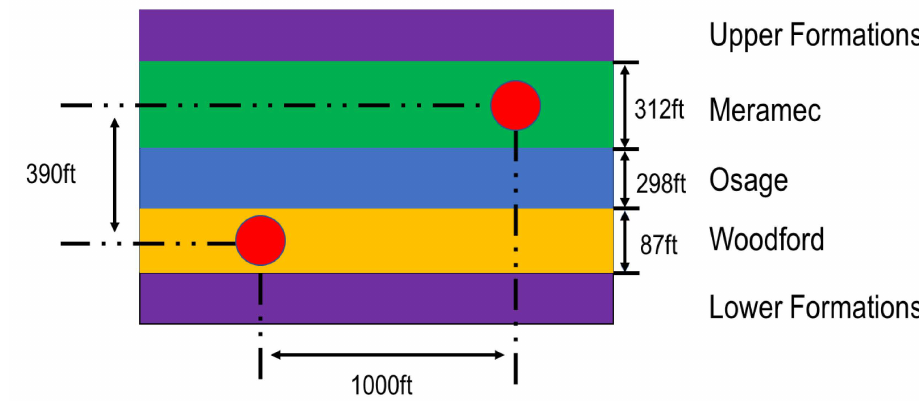
Figure 1. A gun barrel schematic of the location of the two study wells. The well in the Woodford is Well #1 and the well in the Meramec is Well #2. Table 2. Chronology of drilling and production events in the two wells of this study. Time (Days) Event 0 Both wells are drilled, and Well #1 is hydraulically fractured 15 Well #2 is hydraulically fractured 90 Well #1 is put on production 100 Well #2 is put on